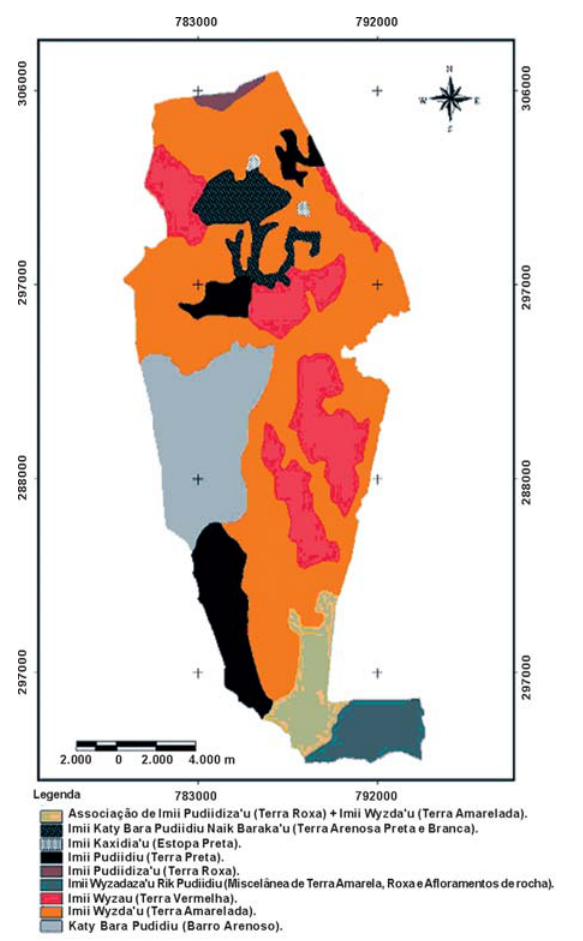
Figura 3. Mapa etnopedológico Uapixana da TI Malacacheta, Roraima,